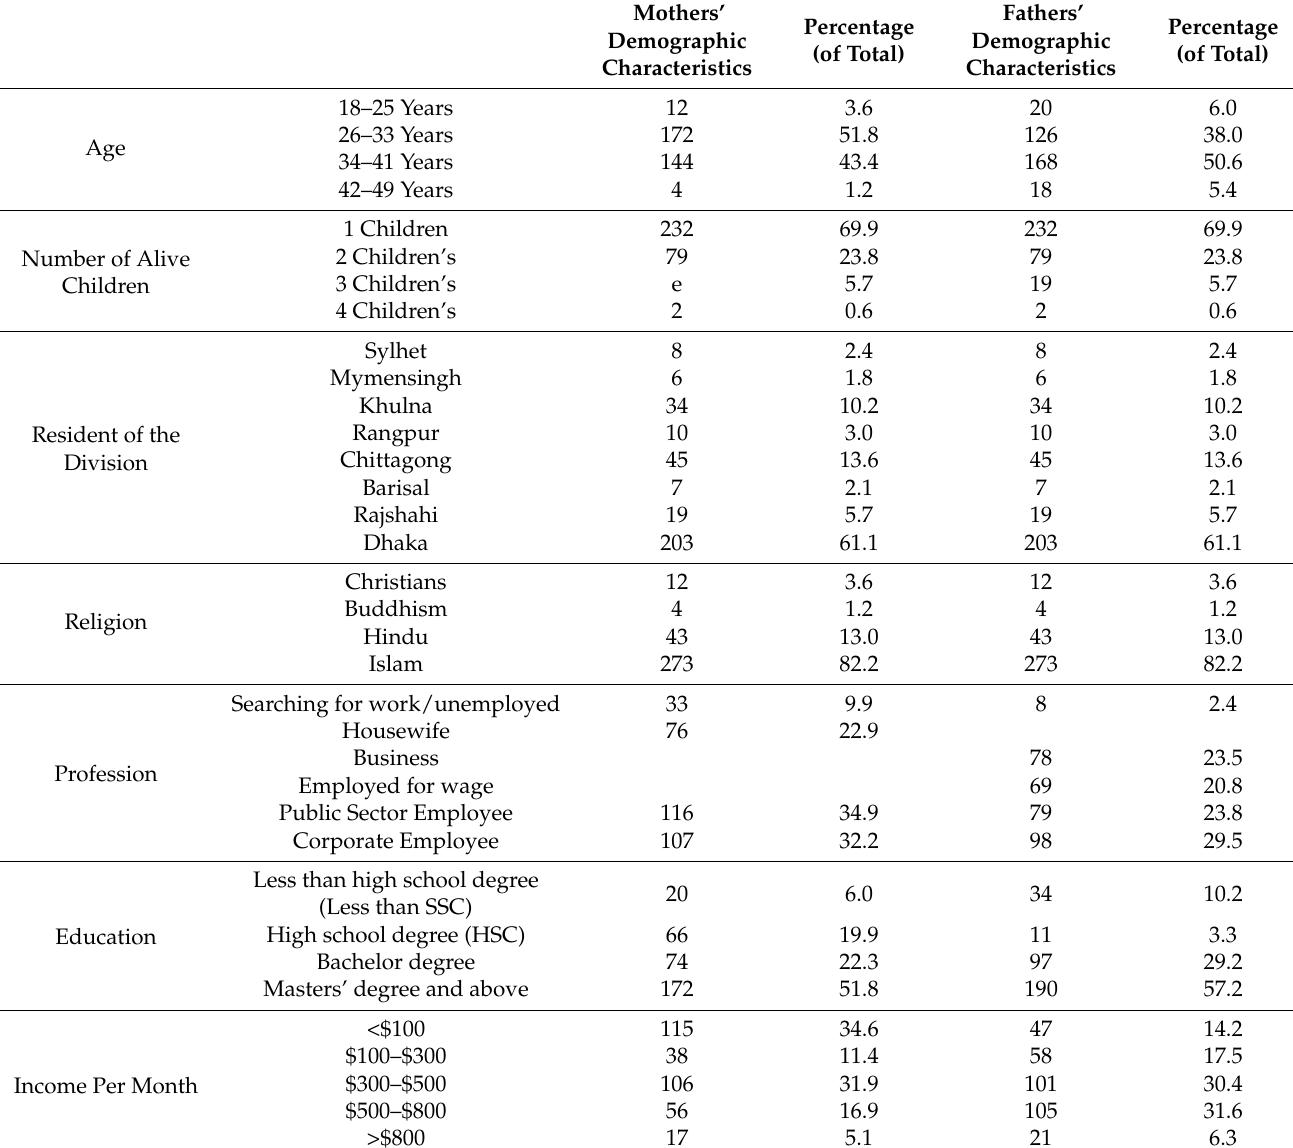
Table A3. Parental demographic characteristics in respect to total participants.